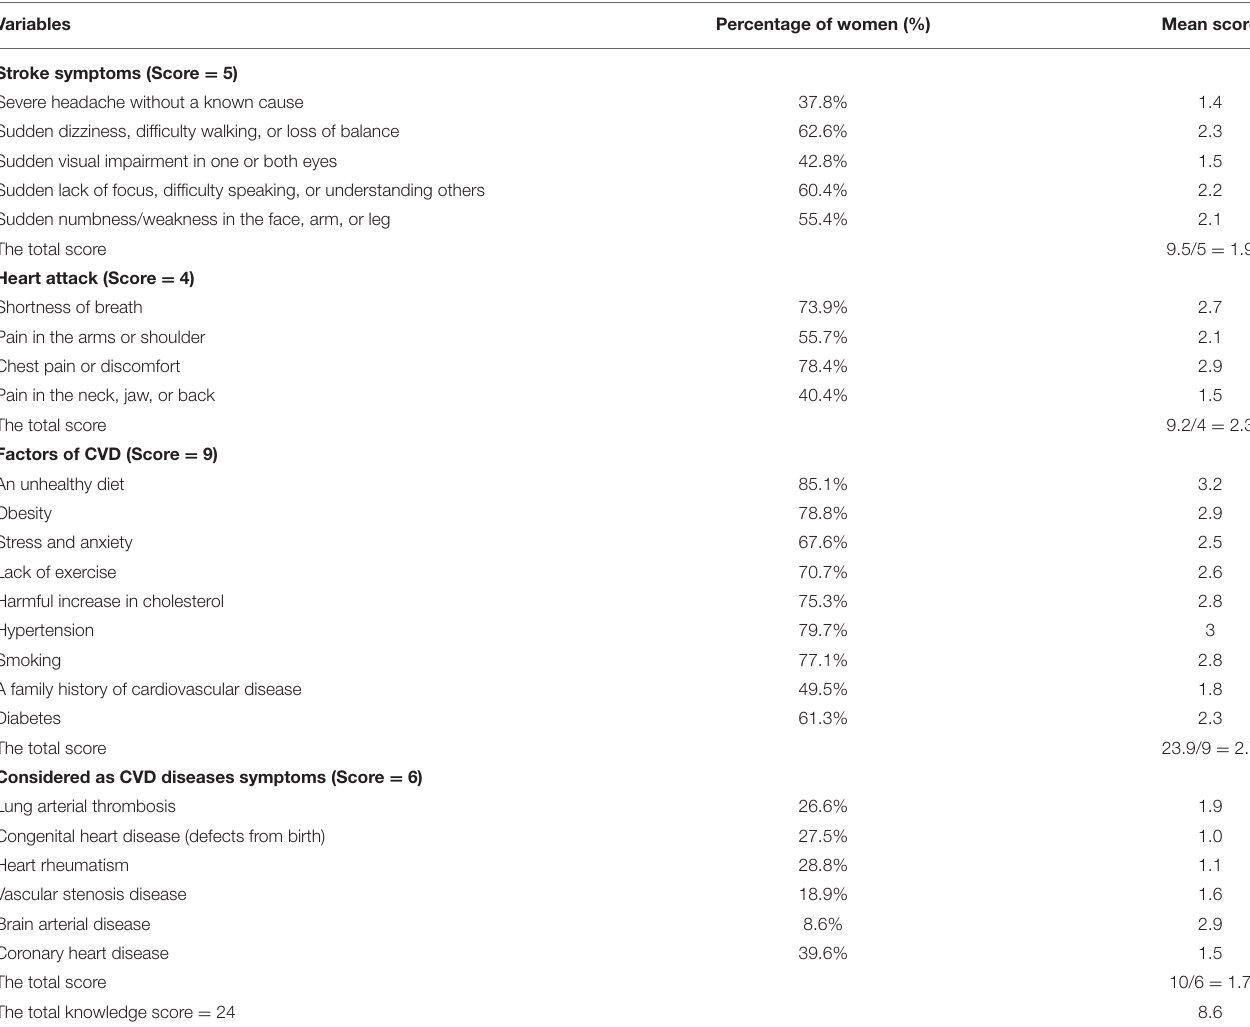
TABLE 3 | Percentage of women giving correct response to CVD risk factors and their response scores. Variables Percentage of women (%) Stroke symptoms (Score =